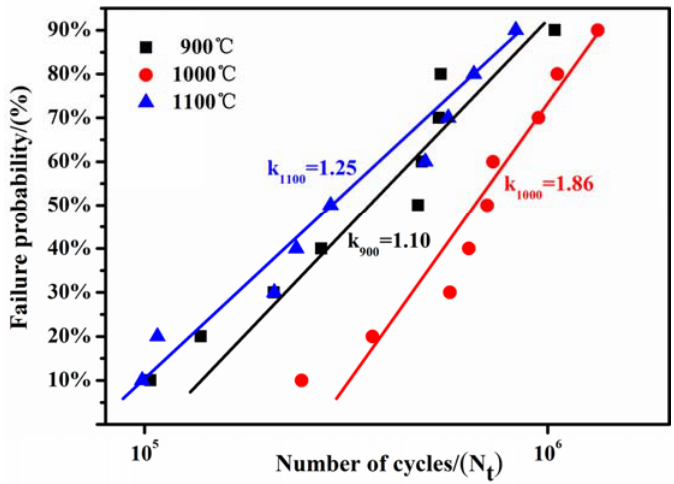
Figure 7. Weibull curves of fatigue life of 17Cr2Ni2MoVNb steel quenched at different temperatures. Table 3. Detail result of test date steel.